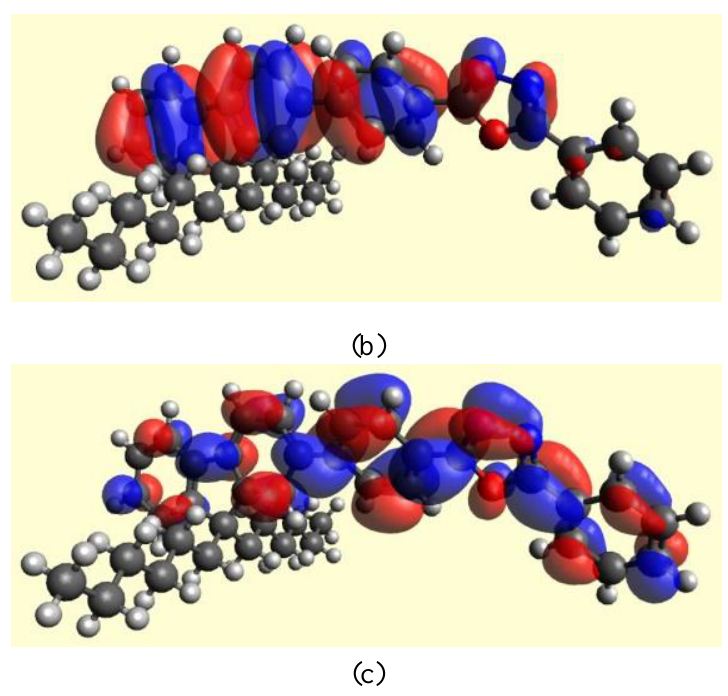
Figure 6. Optimized geometry of a structural unit ( a ), and the spatial distribution of the HOMO ( b ), and LUMO orbitals ( c ).